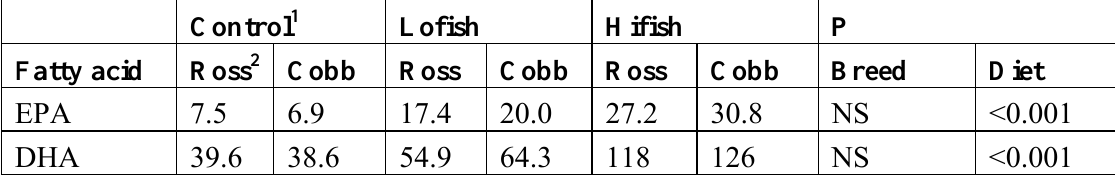
Table 5. Effect of fish oil in the diet and breed of broiler chicken on the mean EPA and DHA concentration (mg/100g meat) in white chicken meat (from